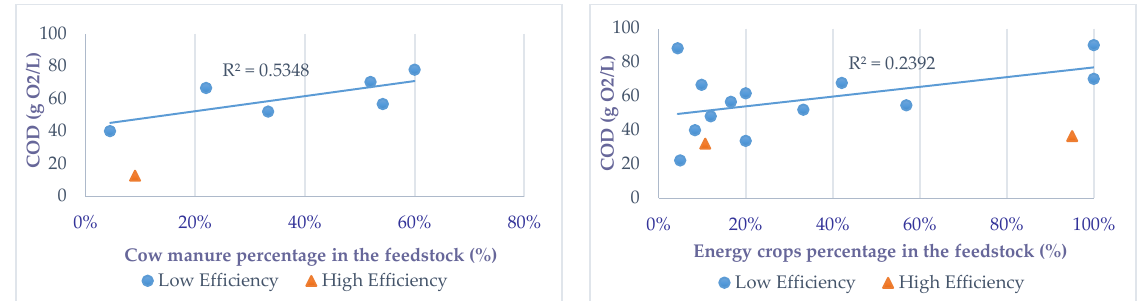
15 of 24 Figure 4. Clustering of feedstocks (Left: High performance solid – liquid-solid separation, Right: Low performance solid – liquid separation). The clustering of low performance solid – liquid separation was less marked regard- ing AD feedstock but can also be separated into two major clusters. The first cluster was predominantly originating either from pig manure, FOG or AFW. Meanwhile, the origin of the second cluster was from the codigestion of cow manure and diverse agricultural and industrial wastes, including sewage sludge. Figure 5 plotted below aims to analyze the influence of substrates ’ composition on the liquid fractions of digestates, specifically on final COD concentration. From the obser- vation, a correlation R 2 = 0.53 ( p value < 0.1) exists between cow manure percentage in the feedstock and the COD concentration. Having a larger sample size made it possible to confirm the observations made by Akhiar et al. [13] with 11 digestates, which also con-